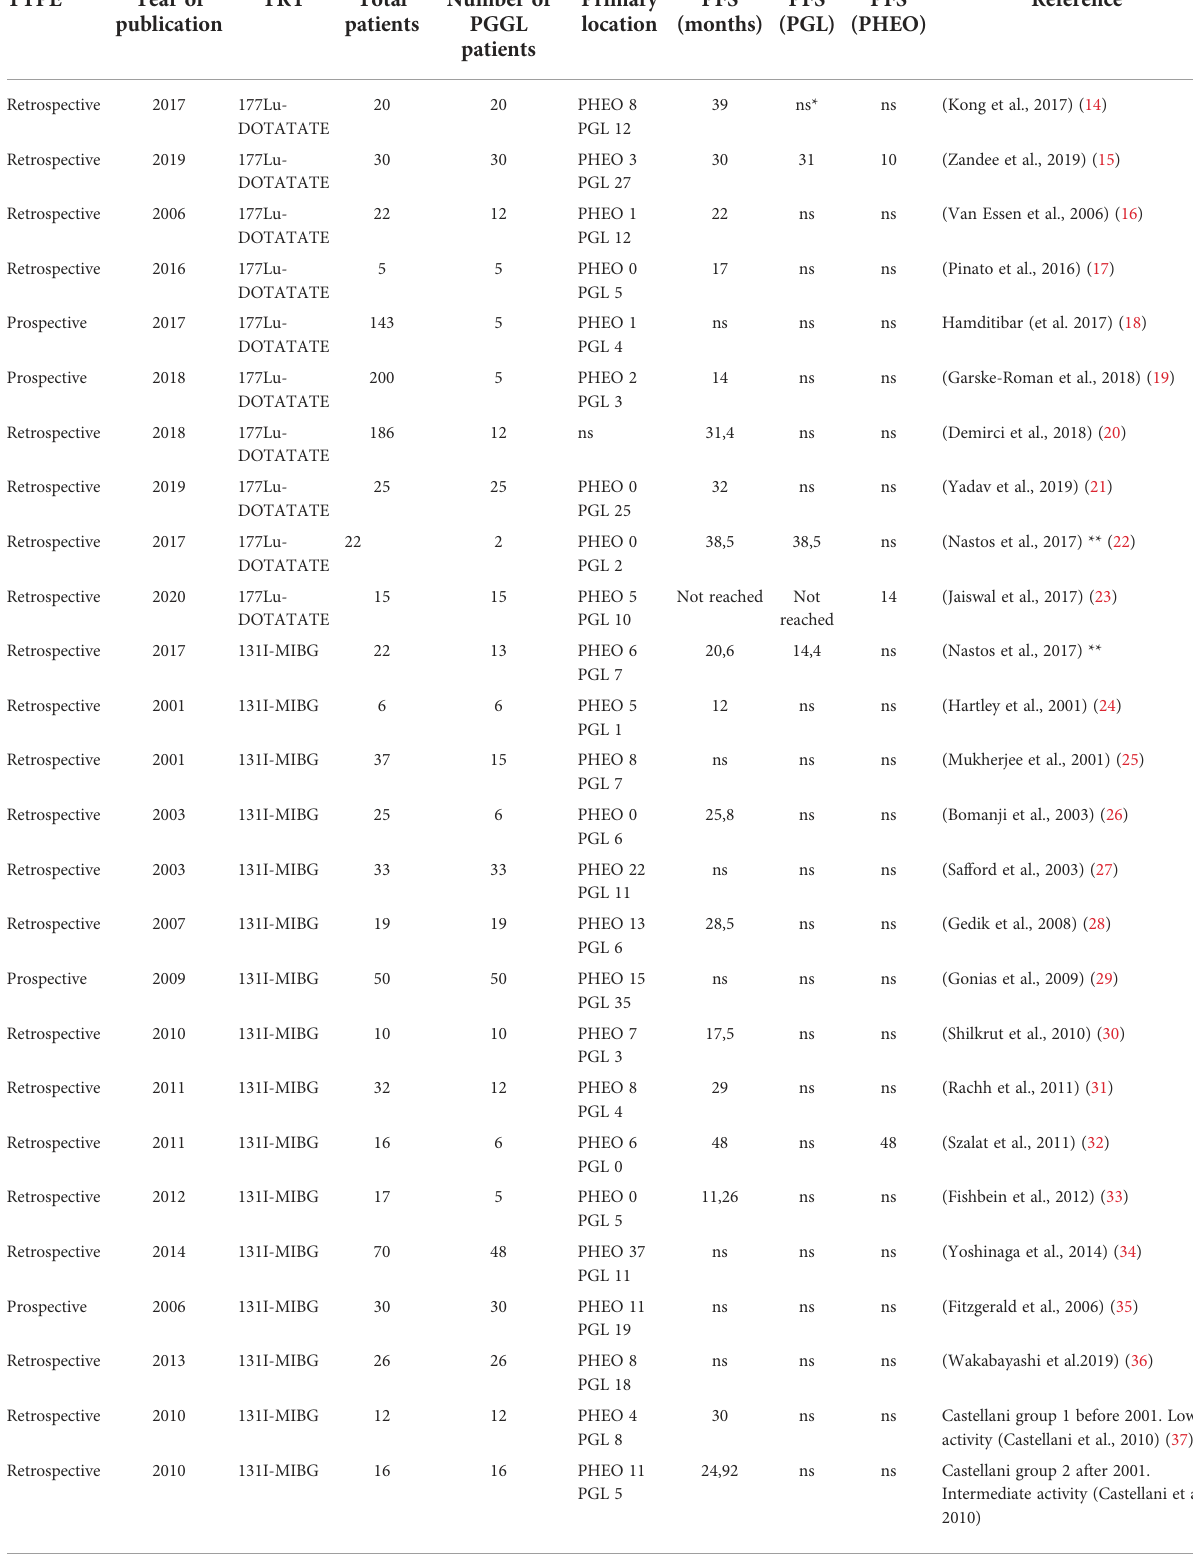
TABLE 2 Studies included in this systematic